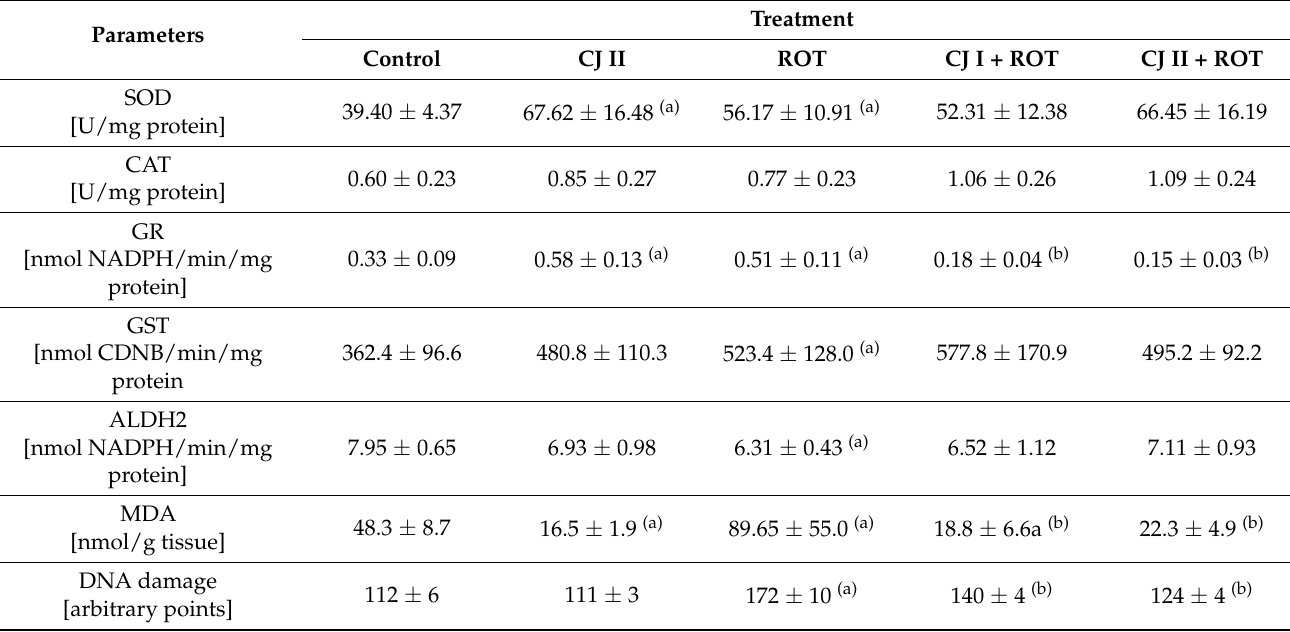
Table 1. Effect of cranberry juice (CJ) on oxidative stress markers in the brain of rotenone (ROT) injected rats. Parameters